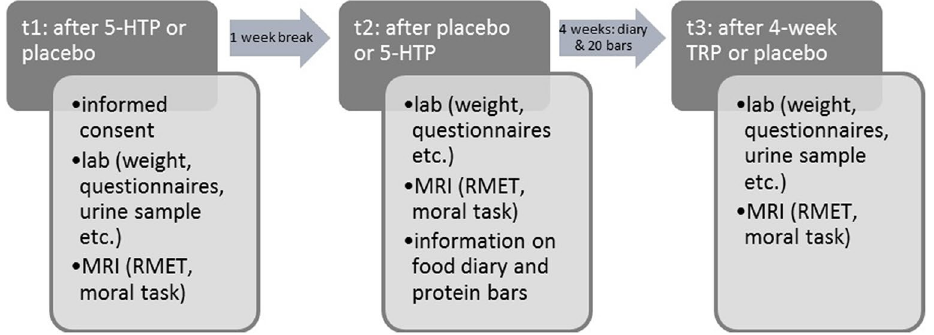
Figure 1. Schematic overview of the study; t1/t2: first part with acute 5-HTP challenge in cross-over design, all participants completed both conditions but at different time points; t3 and placebo condition from t1 or t2: second part with 4-week TRP enriched diet or placebo, every 40 participants completed one of the conditions (mixed between subject design); RMET: reading the mind in the eyes